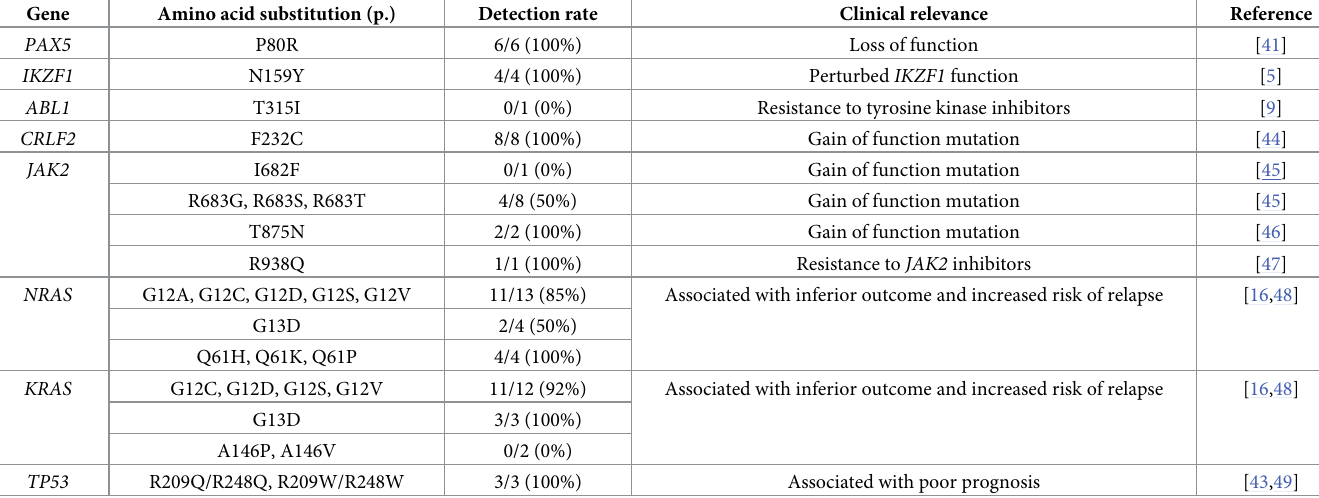
NRAS and KRAS variants at a lower frequency than was reported by GATK (Table 2 and Fig 1). Failure to identify variants in these three genes was attributed to low read coverage or low variant allele frequencies, resulting in fewer than 5 k-mers supporting the variant across each position of the target sequence. A variant occurring in ABL1 went undetected by RaScALL despite high coverage across the genomic region. Inspection of the BAM file revealed an Table 2. Single nucleotide variants targeted by RaScALL. Gene Amino acid substitution